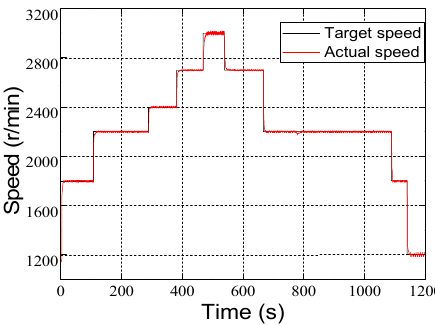
Figure 19. APU speed step response curve.